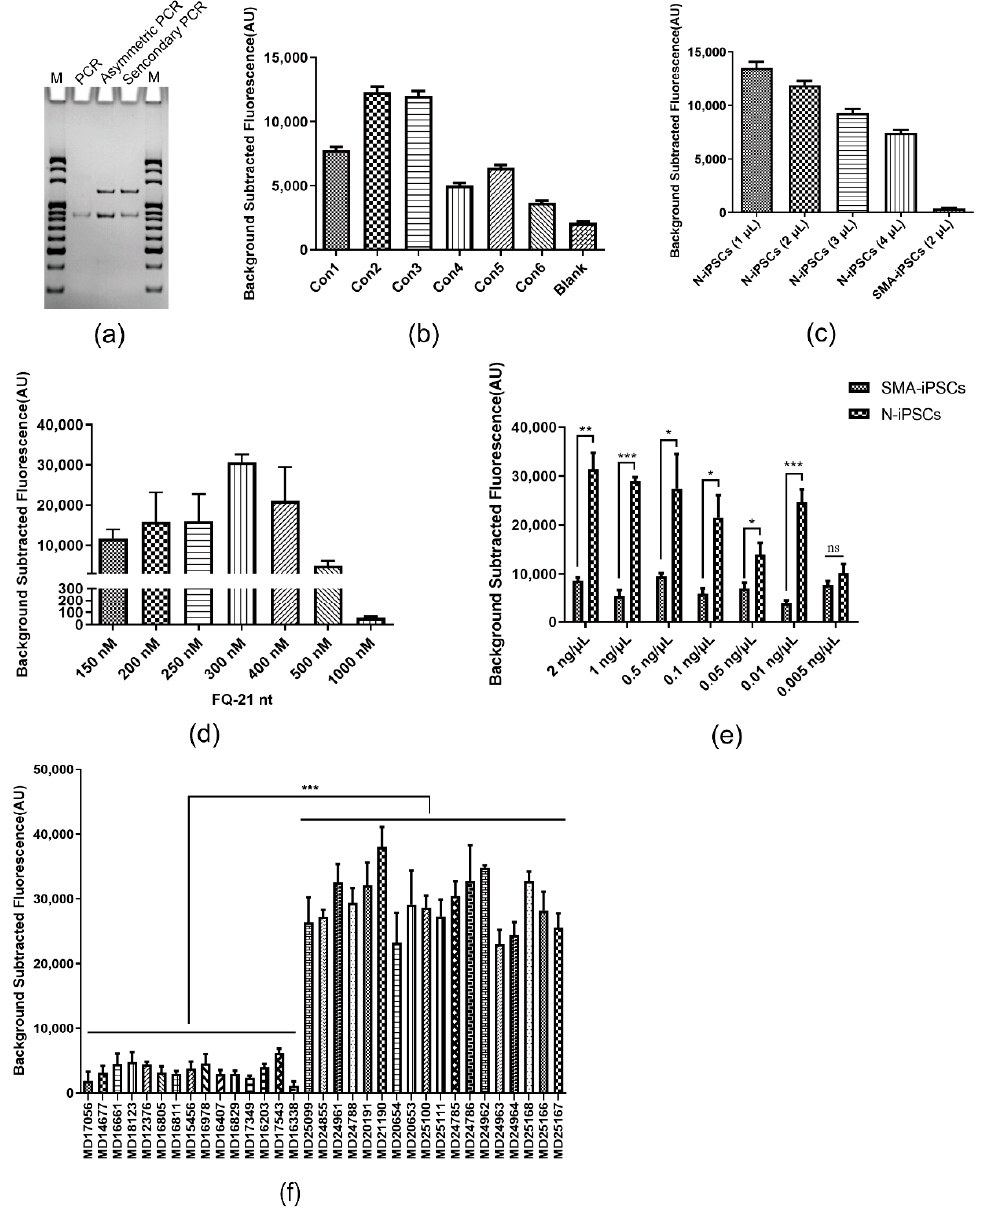
Figure 4. Detection Performance of Asymmetric PCR and SMA-Cas14a1 Assay. ( a ) Products of asymmetric PCR and secondary PCR were identified using electrophoresis. M, 20 bp DNA Ladder